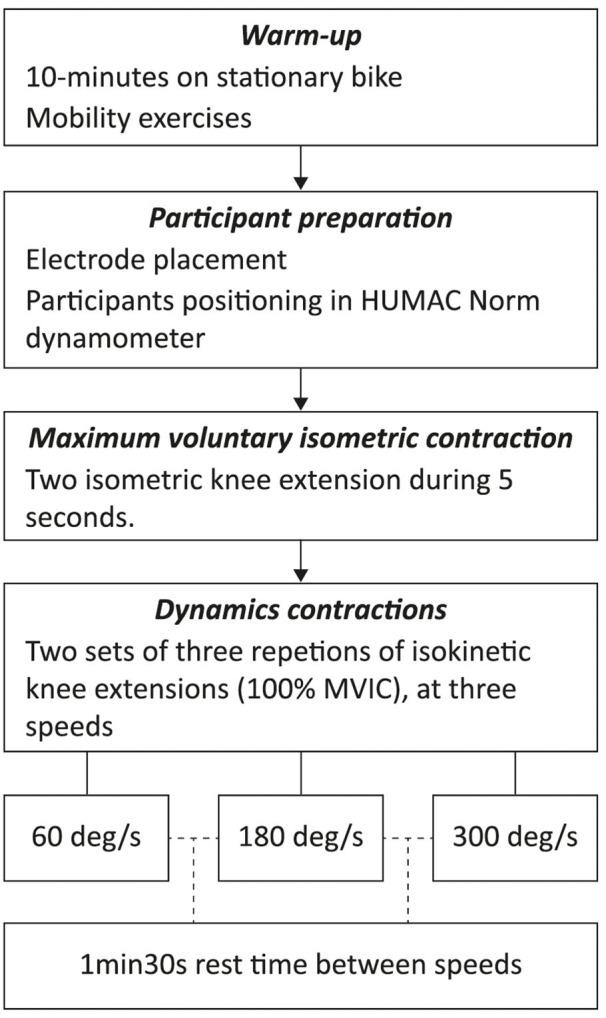
Overview diagram of the validation testing.